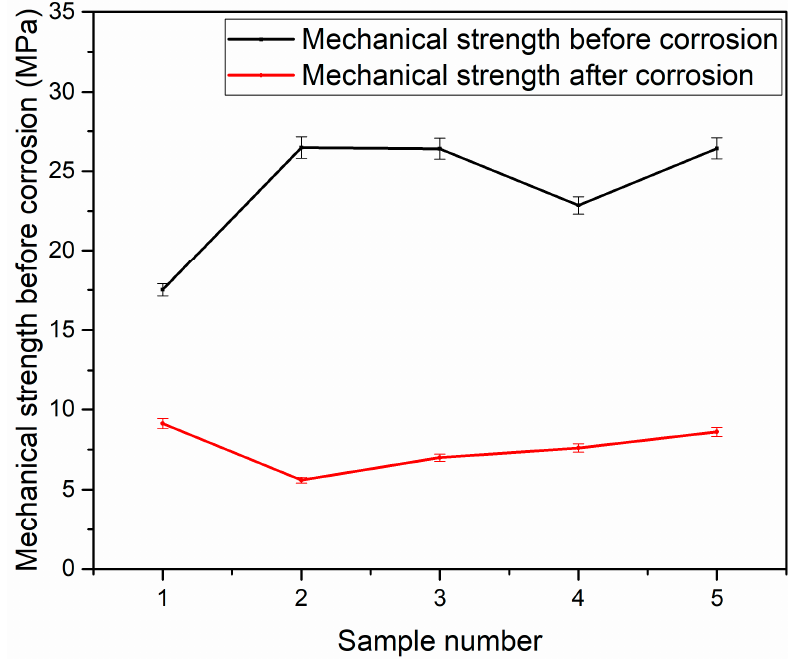
Figure 11. Mechanical strength of support before and after corrosion.